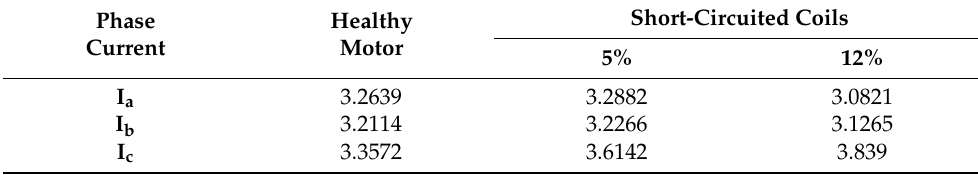
Table 1. RMS value of phase currents.